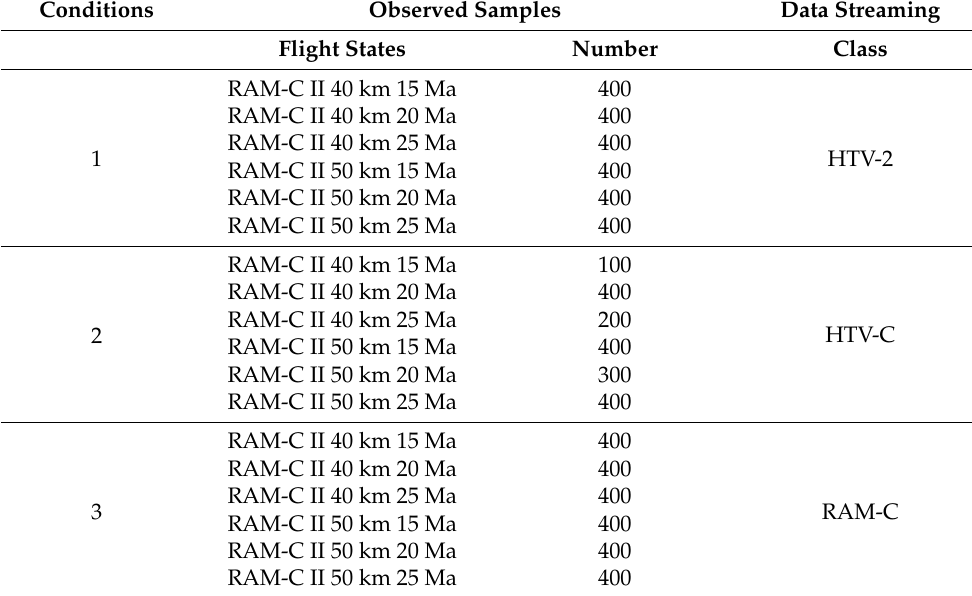
Table 2. Experiment condition